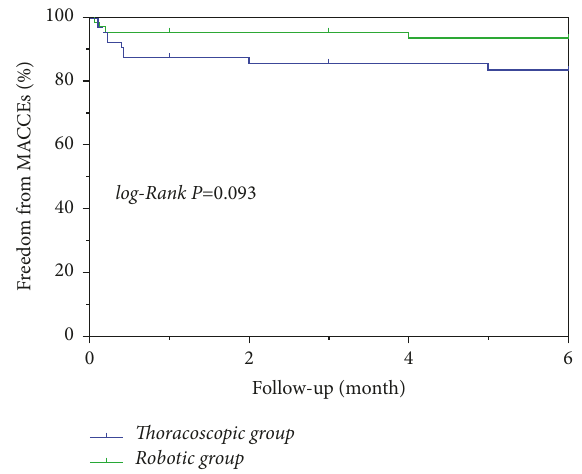
Figure 1: The Kaplan–Meier survival curve. Over 6 months of follow-up, freedom from MACCEs for matched thoracoscopic group and robotic group were 83.6% and 93.4%, respectively ( P � 0 .